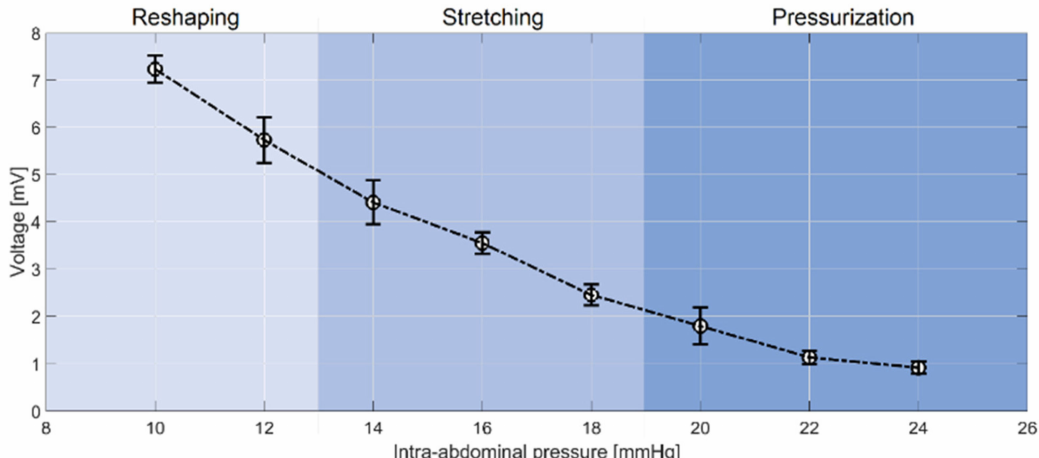
Figure 6. Reflection response of the abdominal wall phantom at different IAP values at 183.6 ns. A quadratic relation was found between IAP and the reflection response of the artificial abdominal wall phantom. Results are represented as mean ± standard deviation.